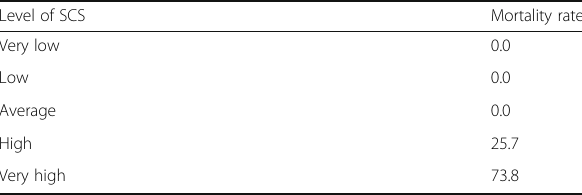
Table 2 (abstract P23). The mortality rate for each level of SCS